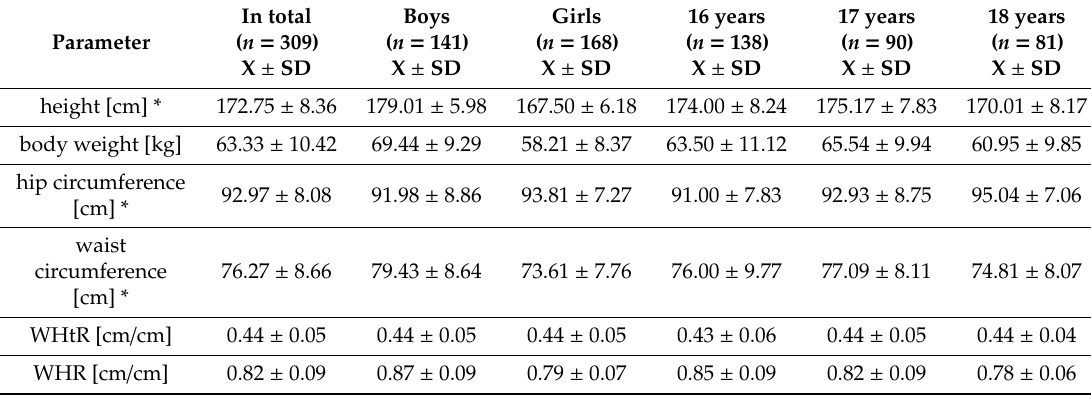
Table 3. Mean values (X ± SD) of anthropometric measurements in total and with reference to gender and